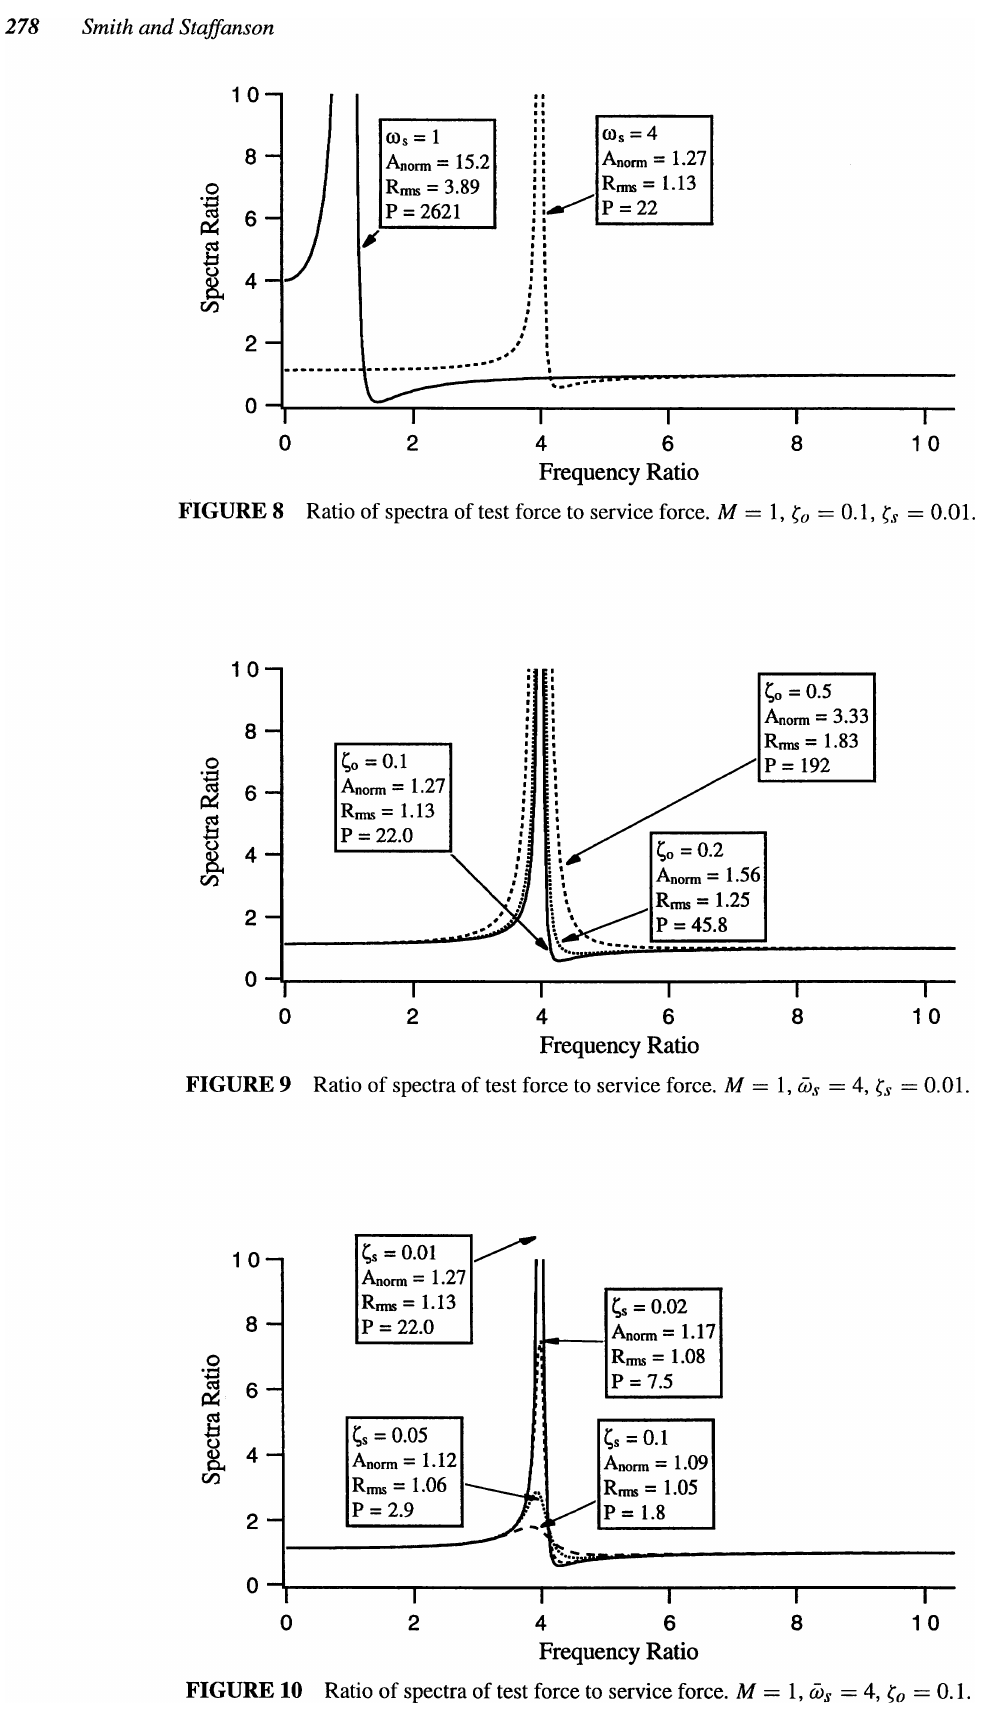
FIGURE 10 Ratio of spectra of test force to service force. M = 1, Ws = 4, (0 =